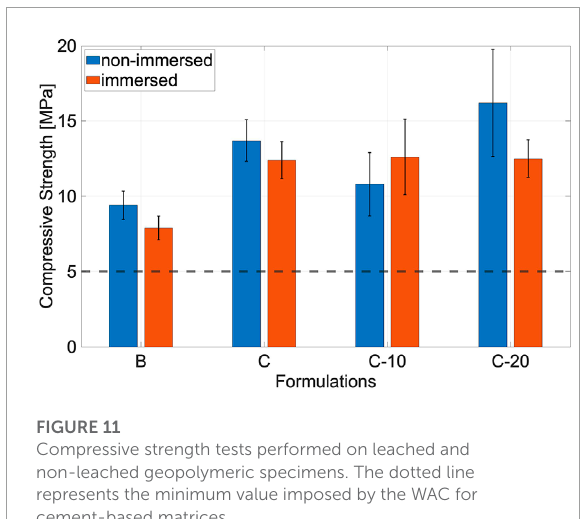
FIGURE 11 Compressive strength tests performed on leached and non-leached geopolymeric specimens. The dotted line represents the minimum value imposed by the WAC for cement-based